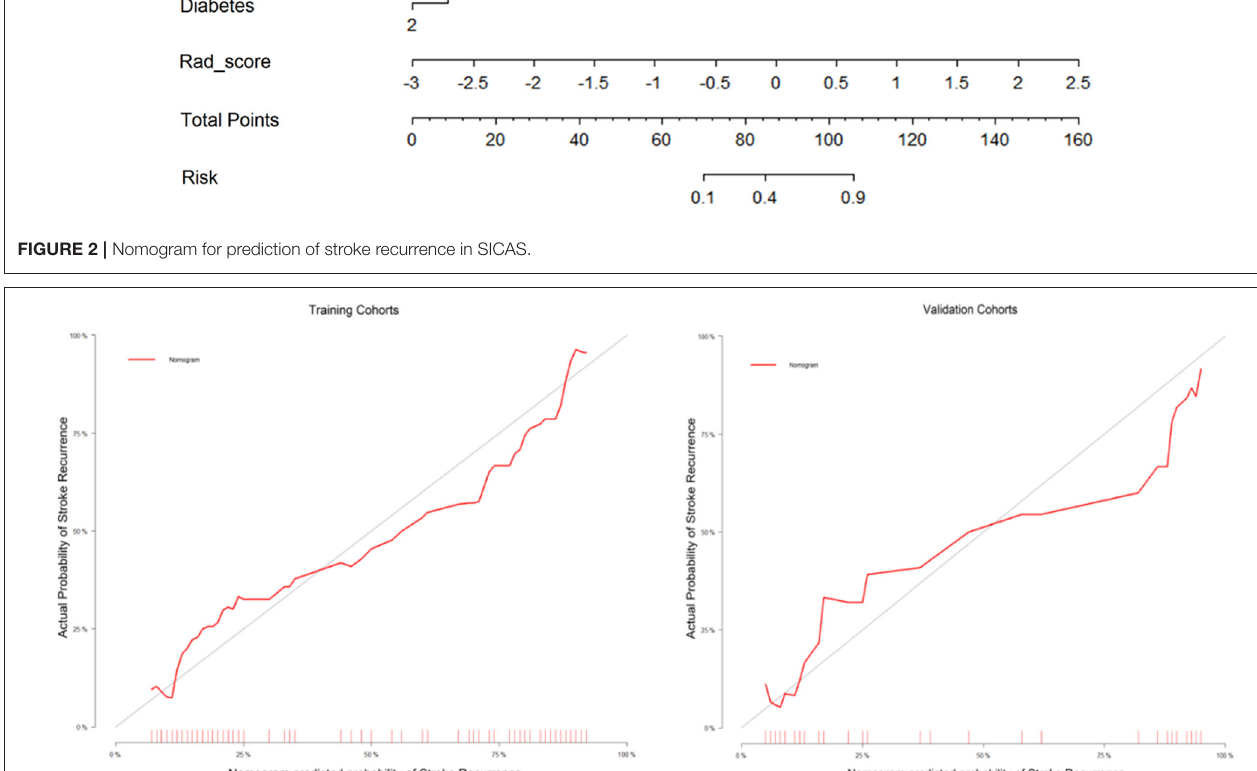
FIGURE 3 | Calibration curves of the nomogram in the training and validation cohorts.